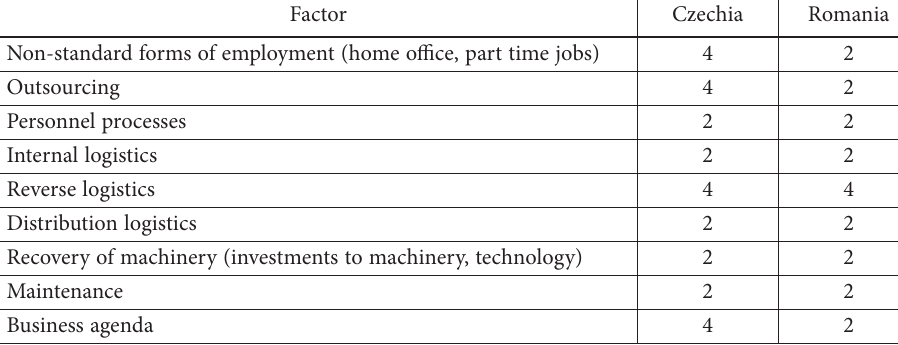
Table 4. Key processes for business – hard skills (source: survey data, compromise solution values, differences are in bold) Factor Czechia